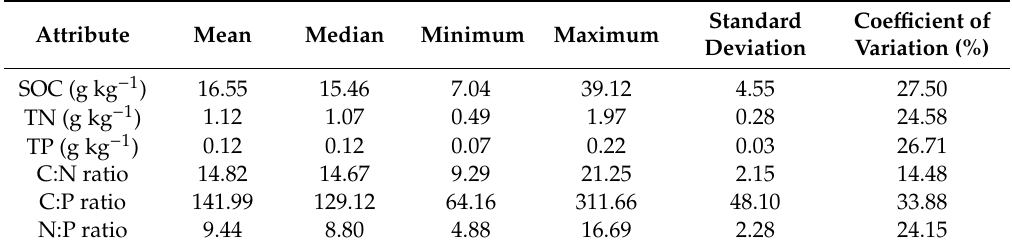
Table 1. Descriptive statistics for soil organic carbon (SOC), total nitrogen (TN), total phosphorus (TP), and C:N:P stoichiometric